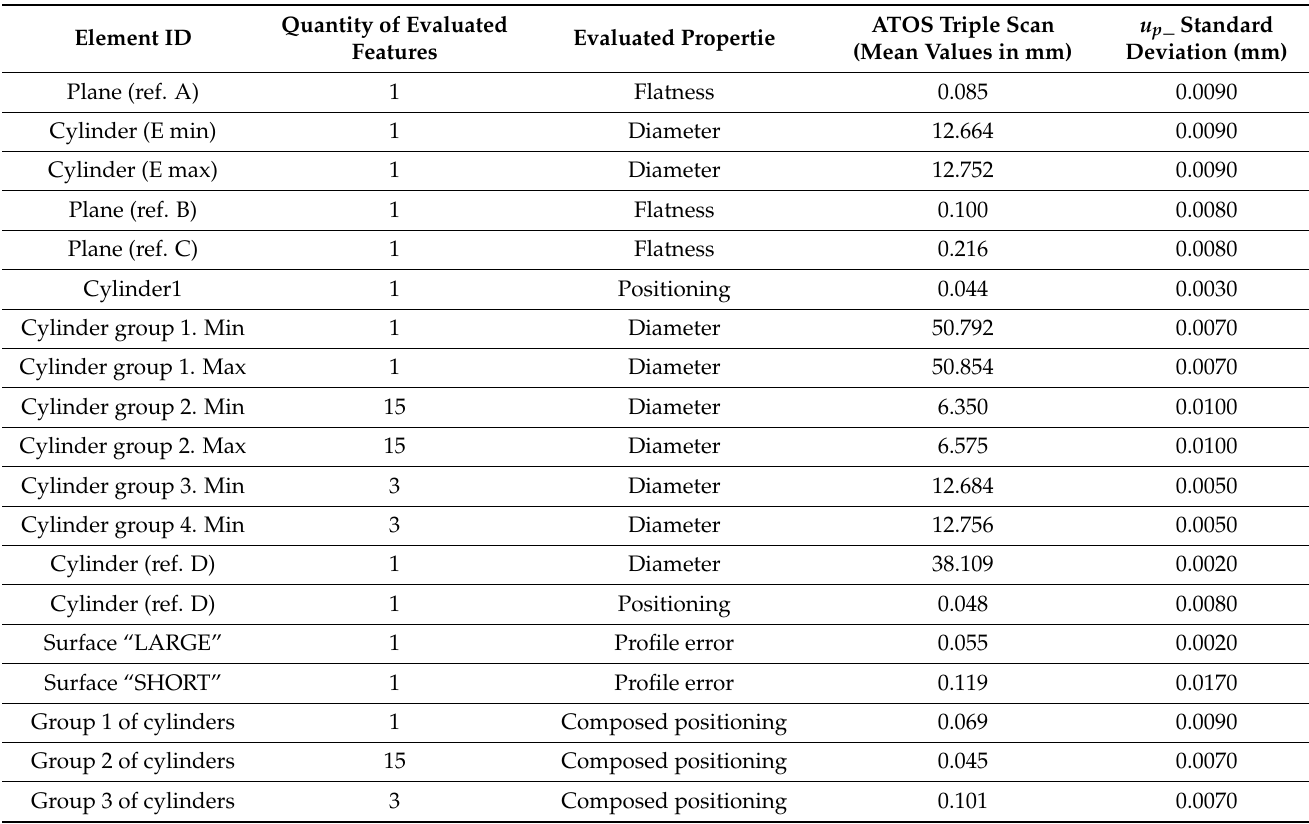
Table 1. ( u p ) uncertainty contributor assessment according to ISO 15530-3 technical